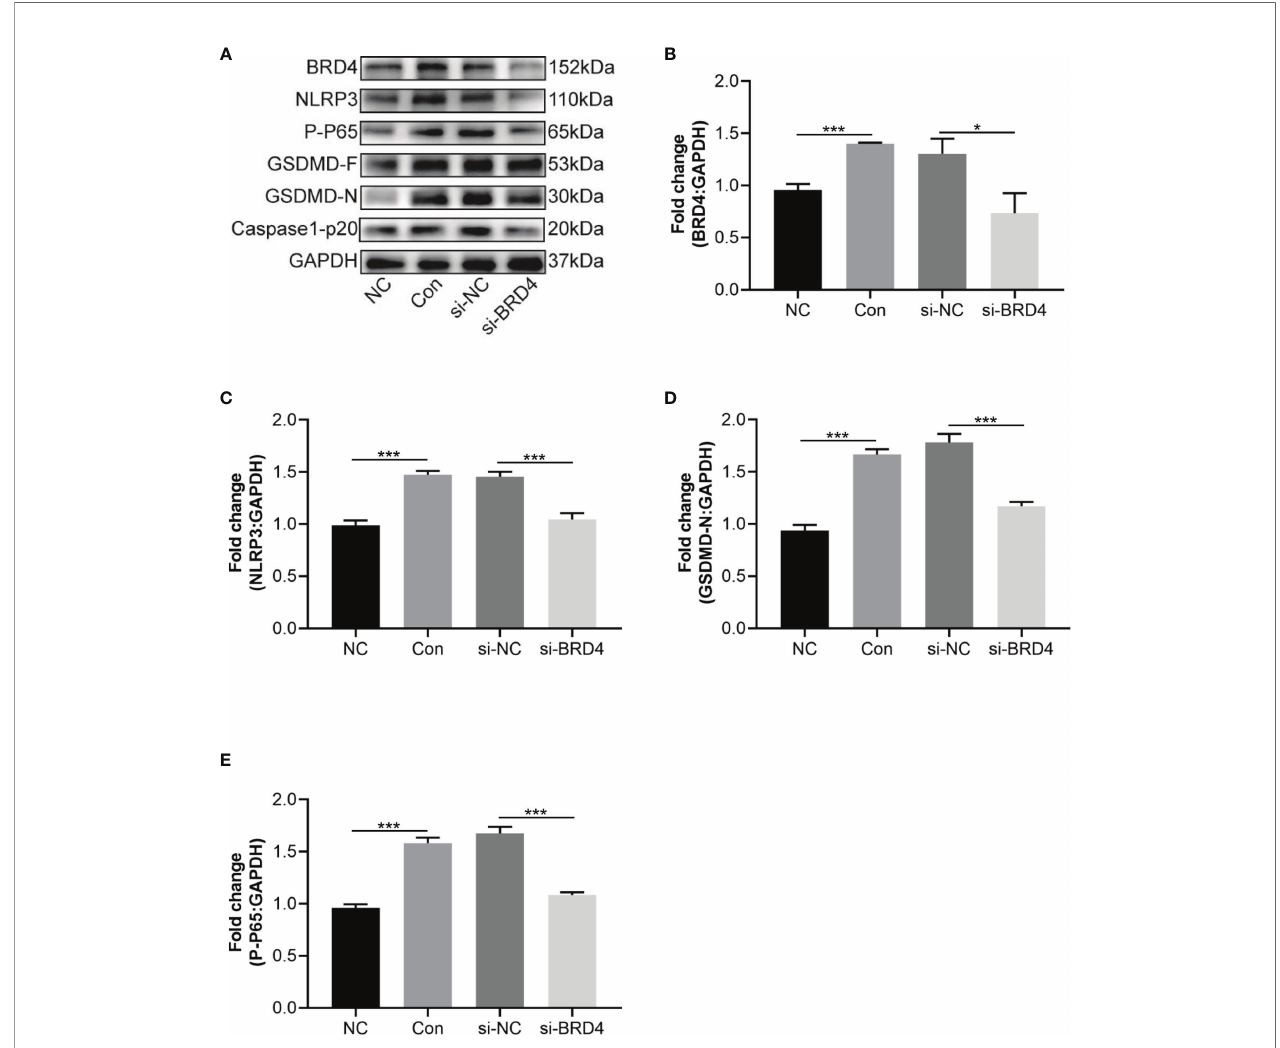
FIGURE 6 | BRD4 knockdown attenuates LPS and ATP-induced HT22 cells pyroptosis. (A) Western blot tested NLRP3, GSDMD-F and GSDMD-N in HT22 cells transfected si-RNA targeting BRD4 for 48 h and then stimulated with LPS (1 m g/mL) and ATP (5 mM) for 30 min. (B – E) Semiquantitative analysis of NLRP3, GSDMD-F, GSDMD-N and P-P65. Data are presented as mean ± standard deviation (SD) of three independent experiments. (*P < 0.05, ***P <